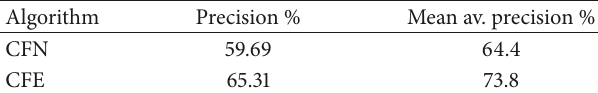
Table 7: Precision and mean average precision values.